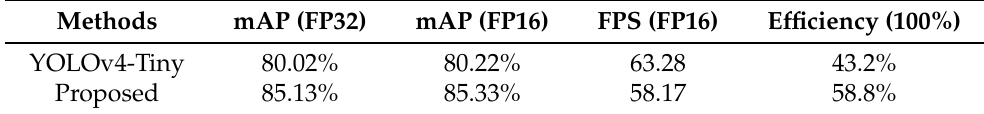
Table 14. Measured accuracy, speed, and efficiency on the NVIDIA Jetson Xavier NX